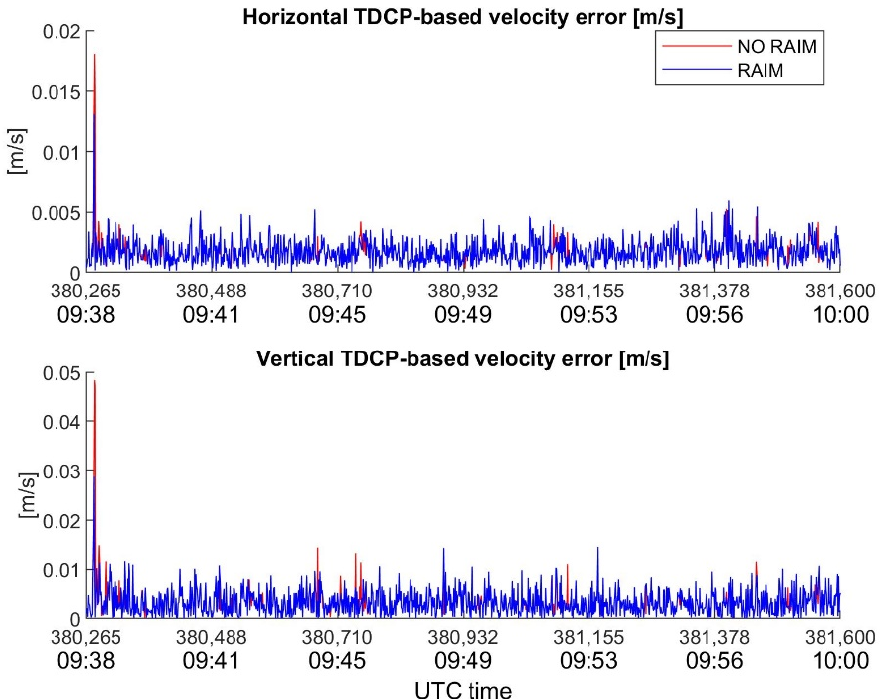
Figure 10. Novatel horizontal and vertical TDCP-based velocity errors as function of time, with and without RAIM application.